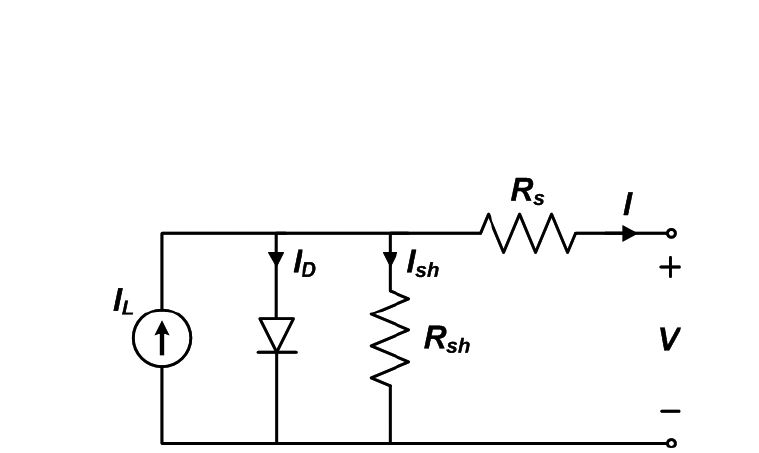
Fig. 4. – Equivalent circuit of a solar cell. Simplistic circuit modelling of a solar cell, with a current generator and a diode in parallel to it to show the diode-like behaviour. Series and shunt resistances are added in series and parallel, respectively, to account for non-idealities in real device behaviour and changes to the current-voltage